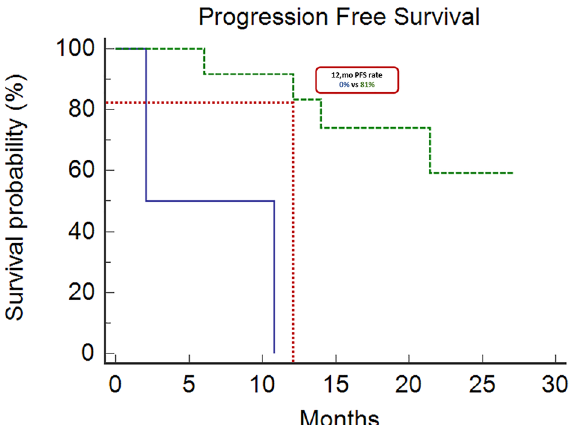
Figure 1. Progression Free Survival: The median PFS was not reached in CDX-2-positive patients (dotted/ green line) versus 2.07 months (95%CI 2.07–10.8) in CDX2-negative patients (continuous/blue line) ( p = 0.0011) The proportion of patients without disease progression at 12 months was 81% in the CDX-2-positive group. All the two CDX-2-negative patients had discontinued treatment due to disease progression.